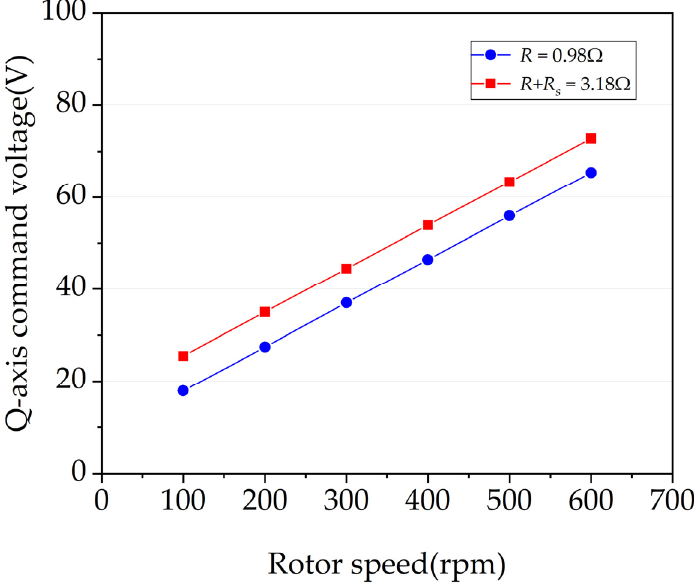
Figure 8. Measured q -axis command voltage with respect to rotor speed ( N = 5, i d = 0, i q = 3 A).